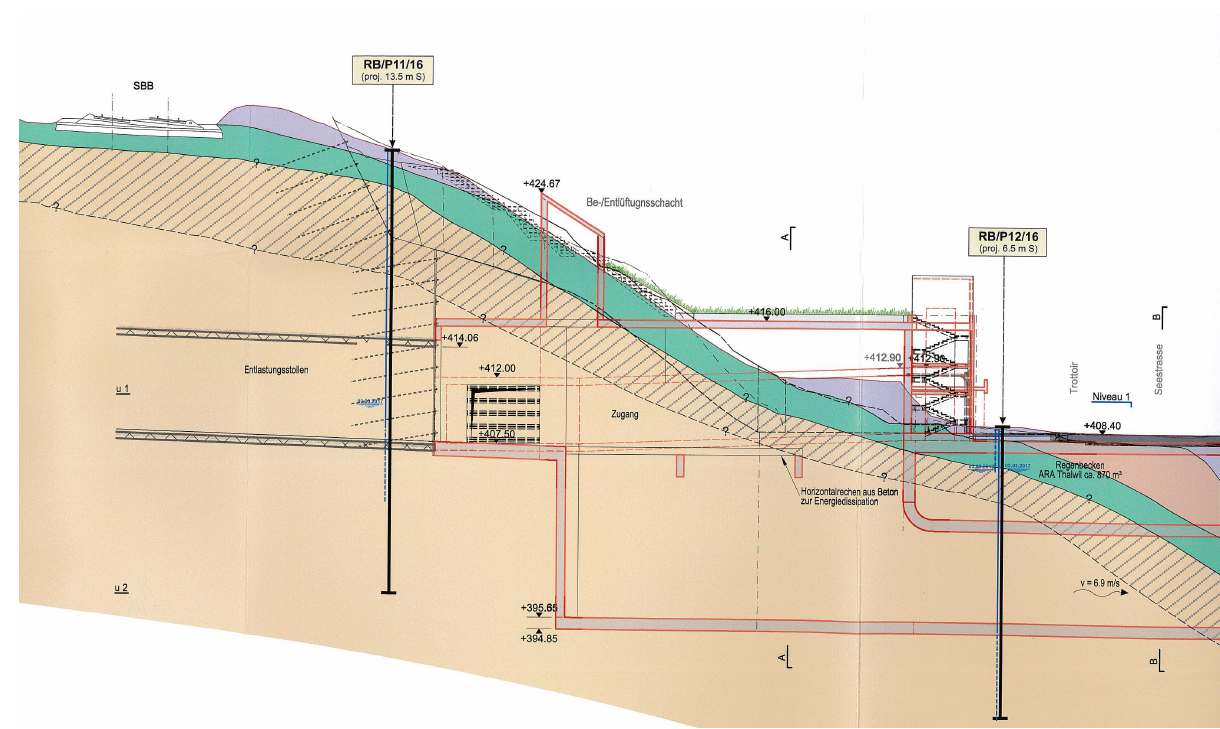
Figure 5. Geological profile through the planned outlet structure.